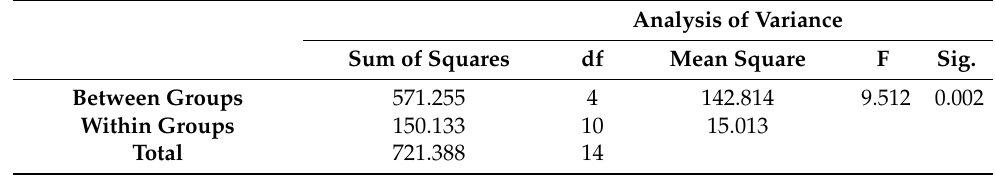
Table 4. Analysis of variance of potential of MEP against the five bacterial strains.